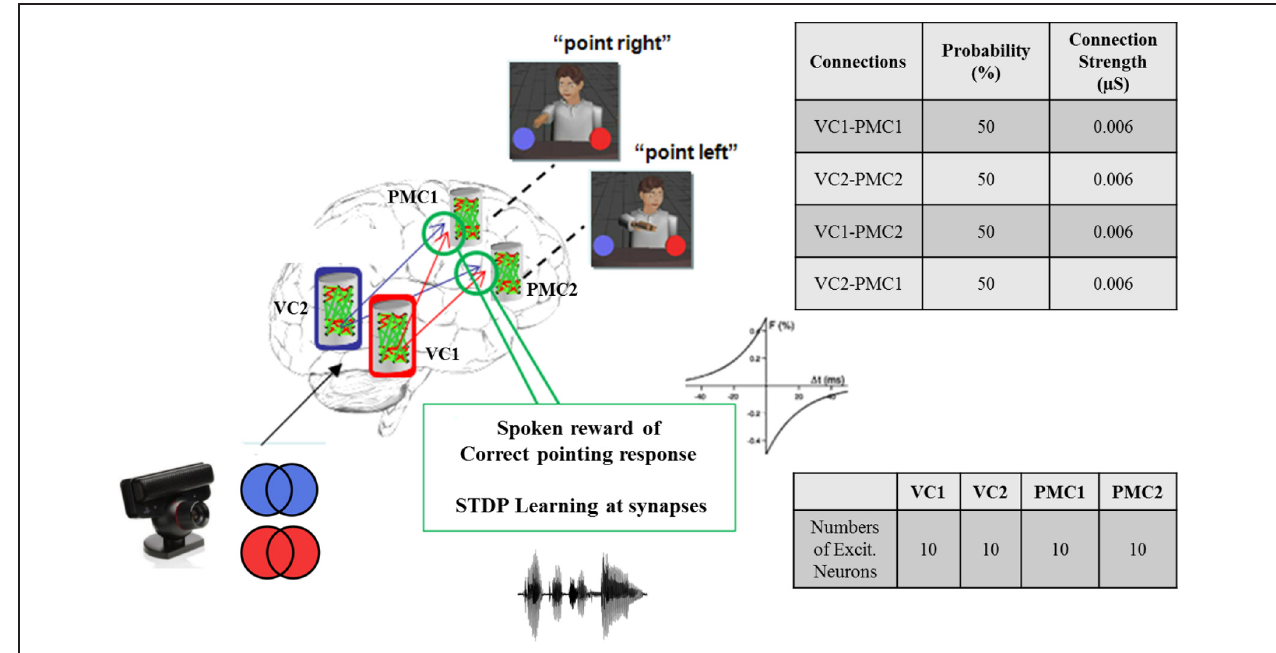
FIGURE 4 | Brain architecture in the virtual neurorobotic interface. Simple spiking neuronal model composed of two areas: the visual cortex (VC) and the premotor cortex (PMC). Each area is divided into two columns VC1, VC2, and PMC1, PMC2 (10 neurons each), respectively. Each VC area has feedforward connections to both PMC regions ( P = 50% and Max. conductance = 0.006 μ S). The synaptic